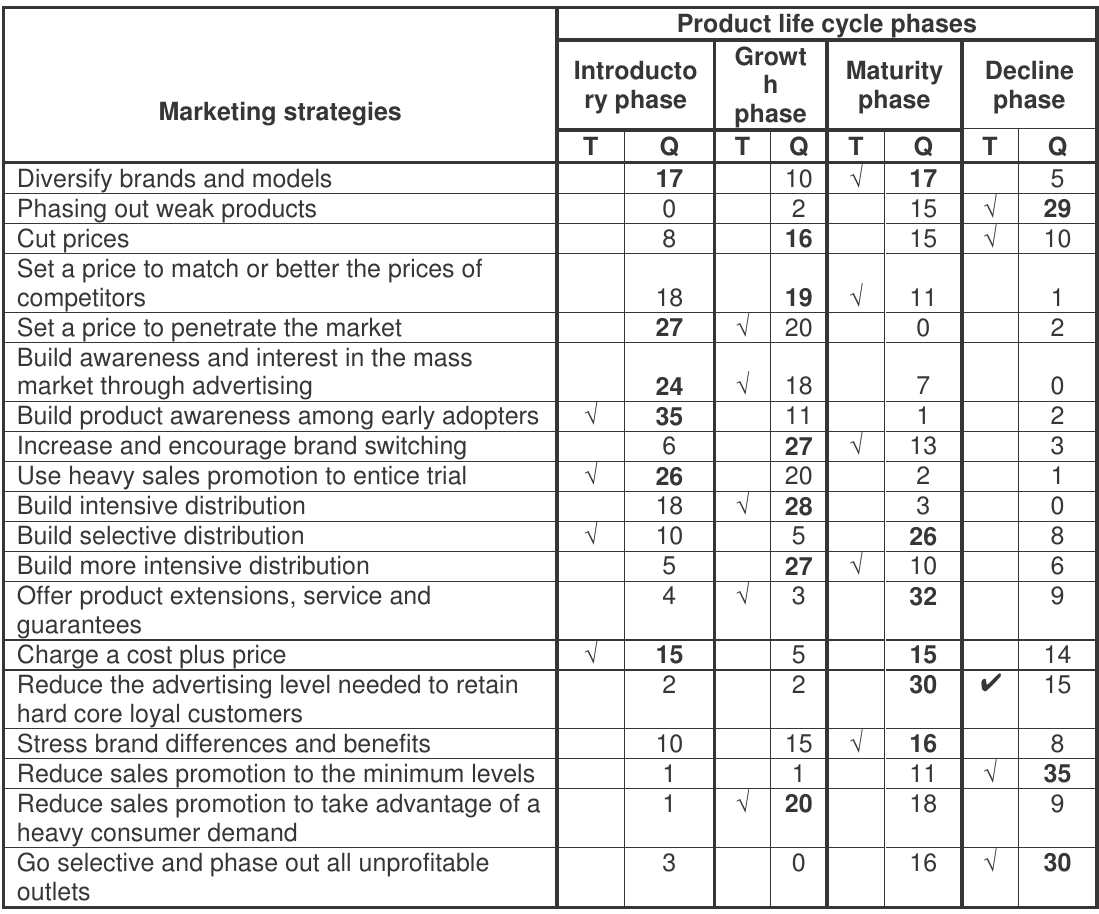
Frequency distribution of the sample in linking the theory on the marketing strategies in each of the PLC phases